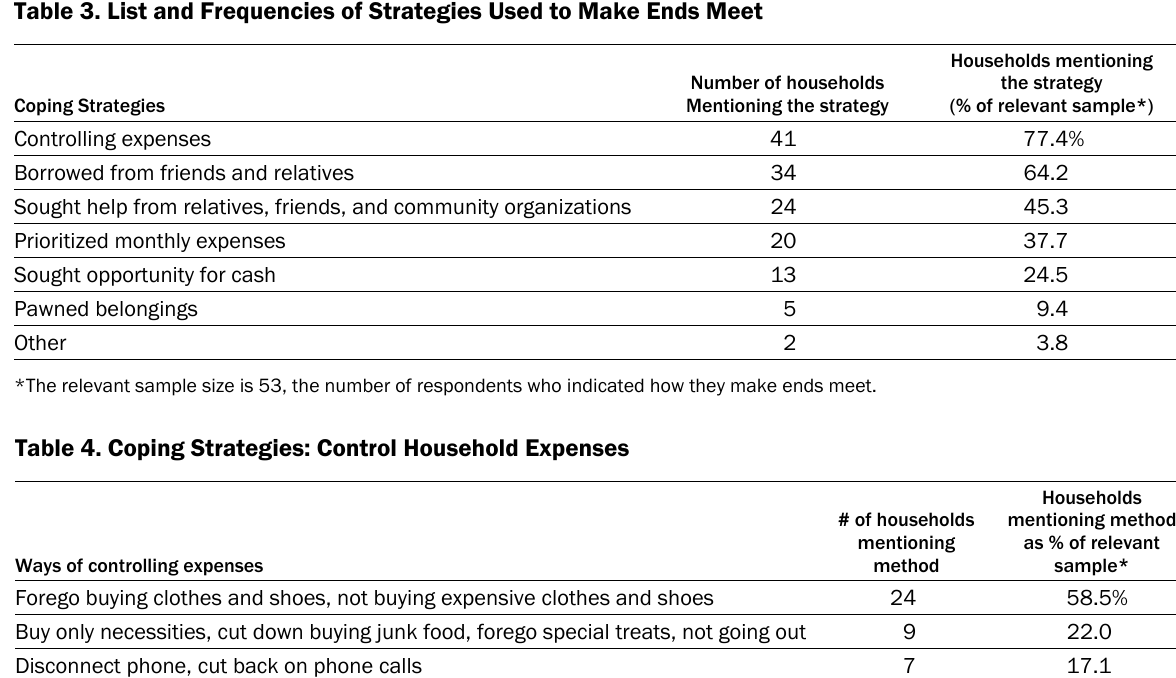
Table 3. List and Frequencies of Strategies Used to Make Ends Meet